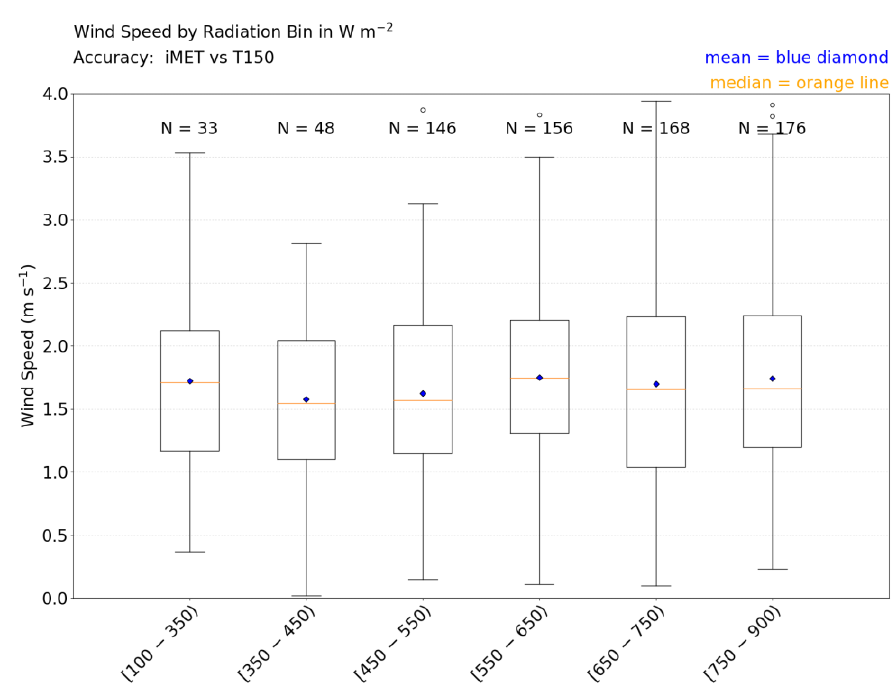
Figure 10. Side-by-side boxplots of wind speed distributions, by solar radiation bin for the daytime Tower experiments. Sample size (N) for each bin is given above each boxplot.